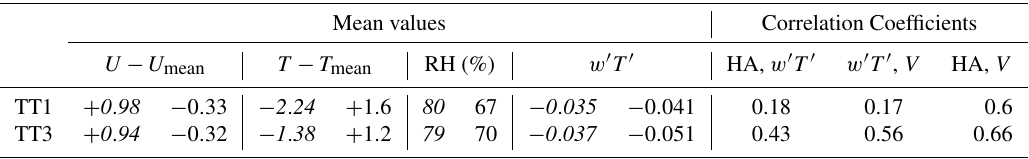
Table 2. Averaged values of normalized air temperatures and wind velocities and of turbulent vertical heat flux ( w (cid:48) T (cid:48) ) at stations TT1 and TT3. Correlation coefficients between (1) vertical turbulent heat flux and horizontal heat advection, (2) between vertical turbulent heat flux and the y wind speed component along the transects, and (3) the horizontal heat advection and y wind speed component along the transects. Values are provided for katabatic (in italics) and disturbed conditions and for stations TT1 and TT3.